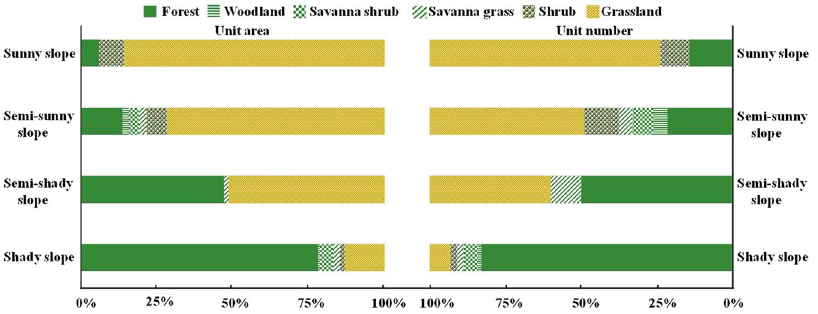
Figure 6. Ratios of spatial unit number and area of different vegetation types according to four slope aspects within the ellipse shown in Fig. 5. This map was generated using Microsoft Excel 2010 software.